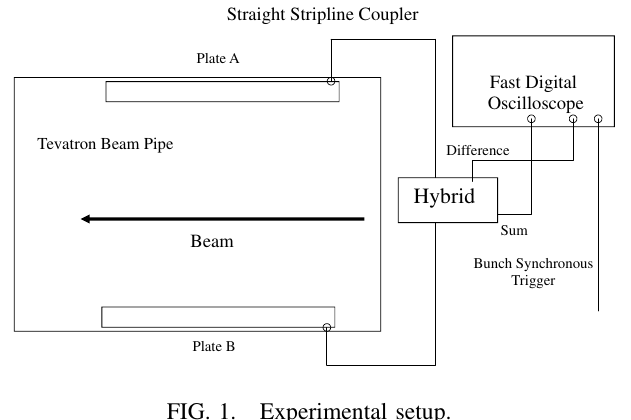
FIG. 1. Experimental